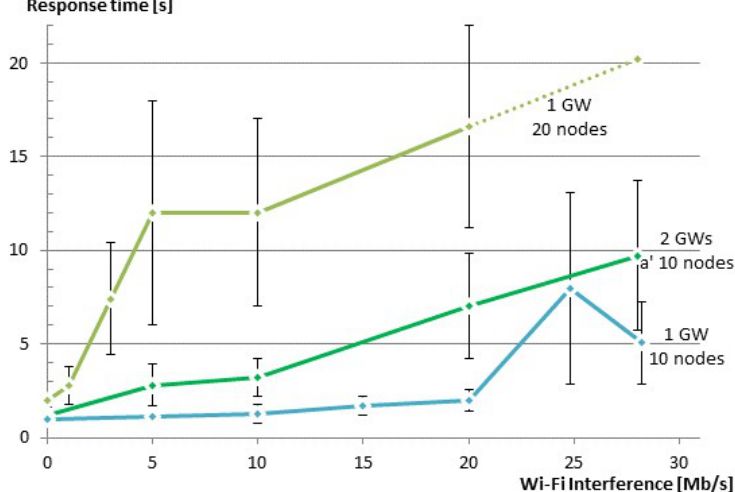
Figure 14. Entity response time of an entity with 10 members in the presence of Wi-Fi interference for varying initial back-off